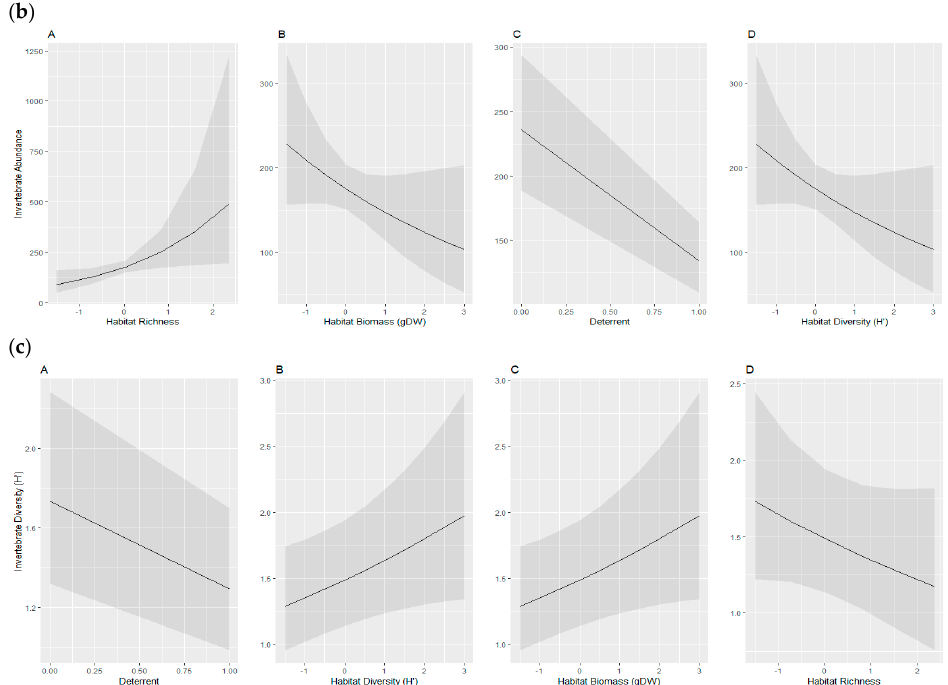
Figure A3. Partial regression plots identifying the effect of each predictor variable on ( a ) epiphyte load